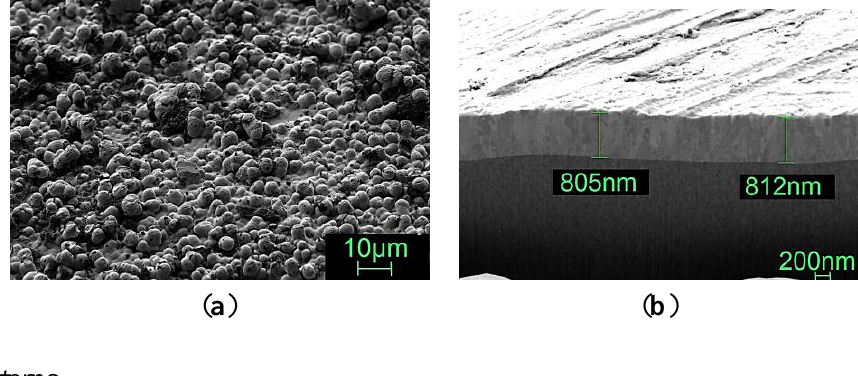
Figure 28. ( a ) Spherical structured surface (Lifetime: 400,000 cycles); ( b ) Smooth surface and Focused Ion Beam System (FIB) cross section of the coating (Lifetime: 55,000